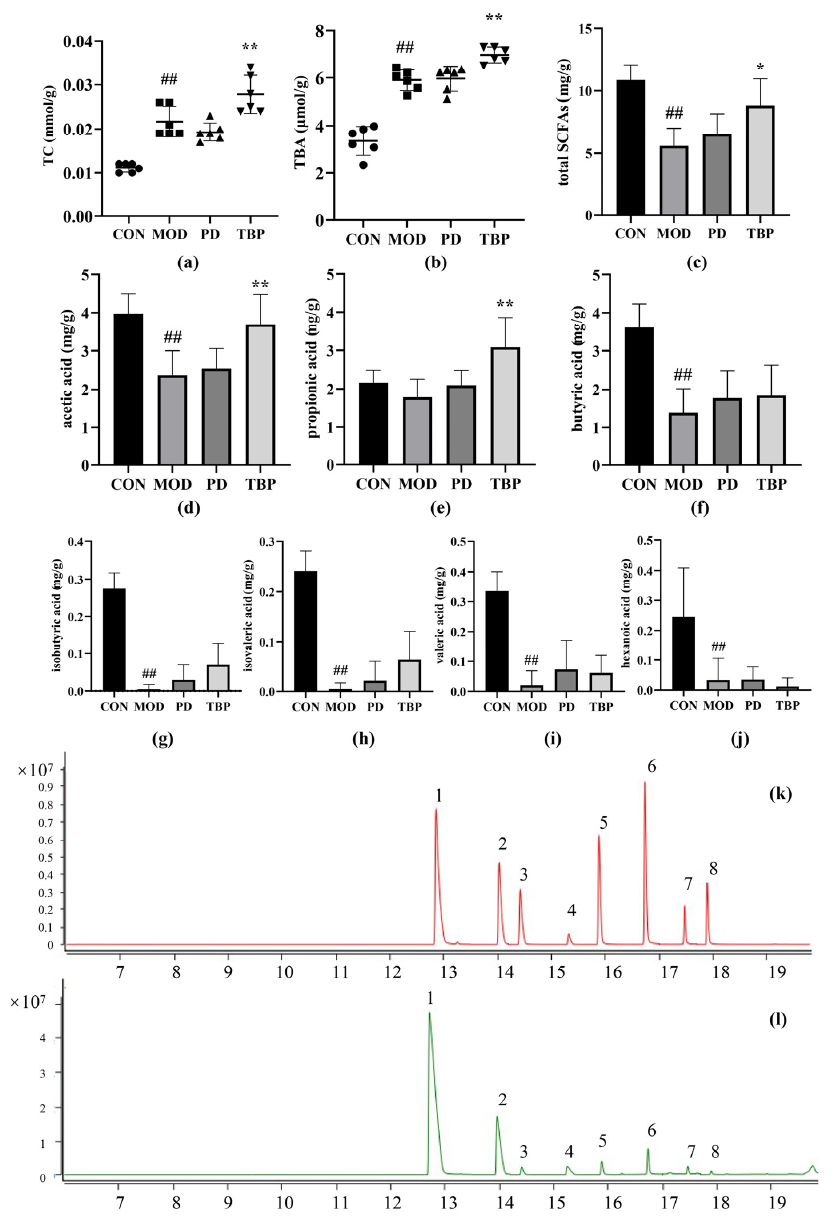
Figure 6. Effects of TBP administration on the fecal TC ( a ) and TBA ( b ) levels in SD rats fed on HFD. Effects of TBP on fecal short-chain fatty acid production: total SCFAs ( c ), acetic acid ( d ), propionic acid ( e ), butyric acid ( f ), isobutyric acid ( g ), isovaleric acid ( h ), valeric acid ( i ), and hexanoic acid ( j